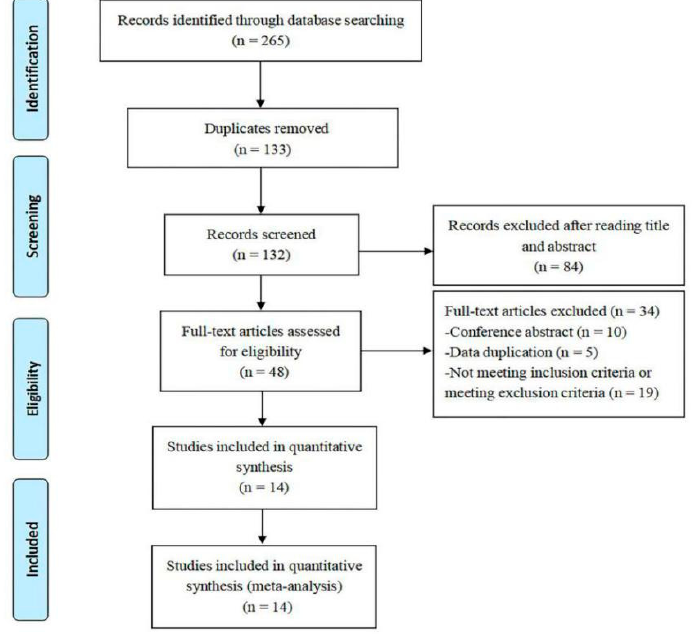
Figure 1. Flowchart of the studies selection process.